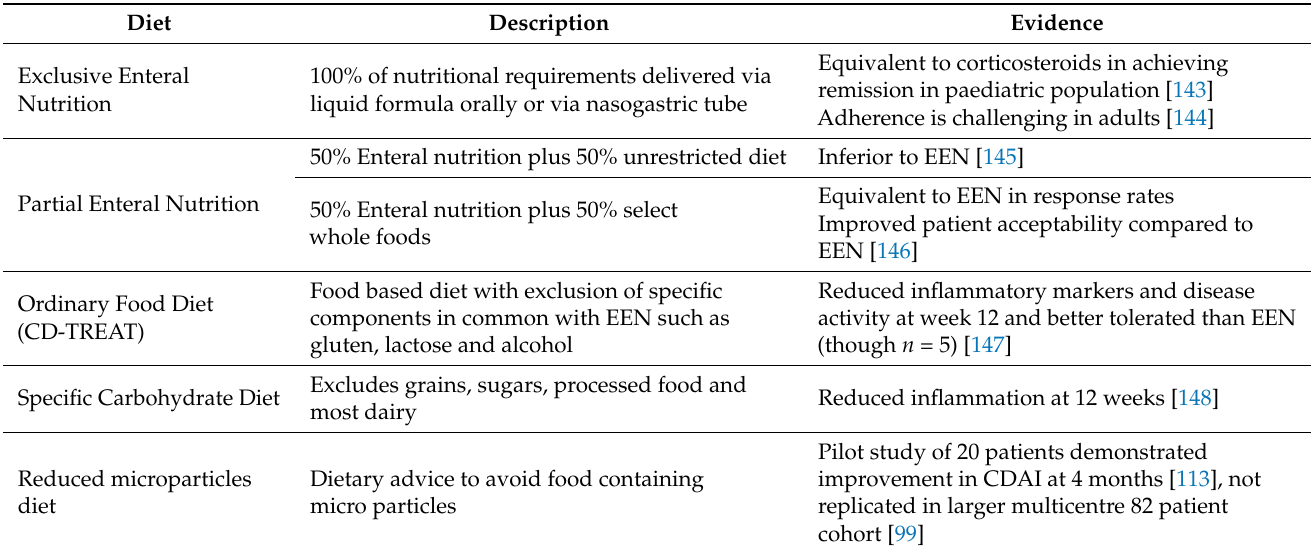
Table 4. Summary of dietary interventions in Crohn’s